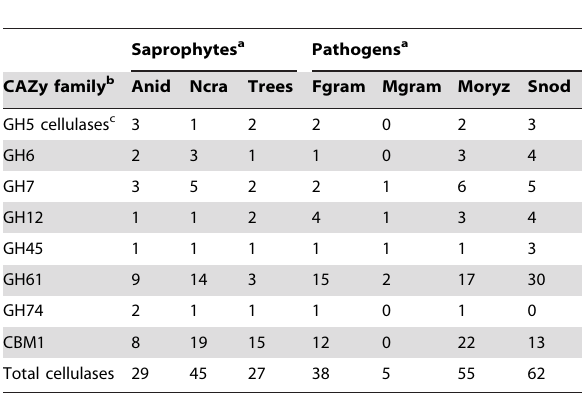
Table 3. Numbers of predicted enzymes degrading cellulose across seven ascomycete species with sequenced